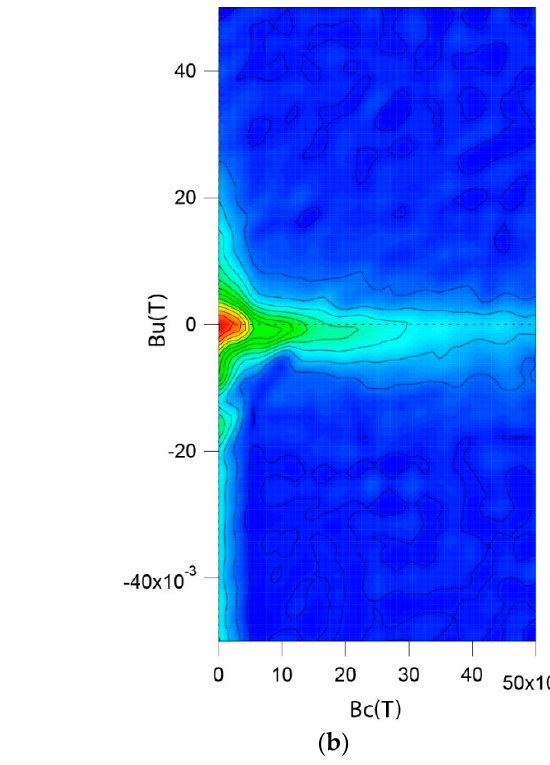
Figure 9. First-Order Reversal Curves (FORCs) for representative samples. ( a ) Lava flow (COG2); ( b ) lapilli (MJ). Table 5. FORC